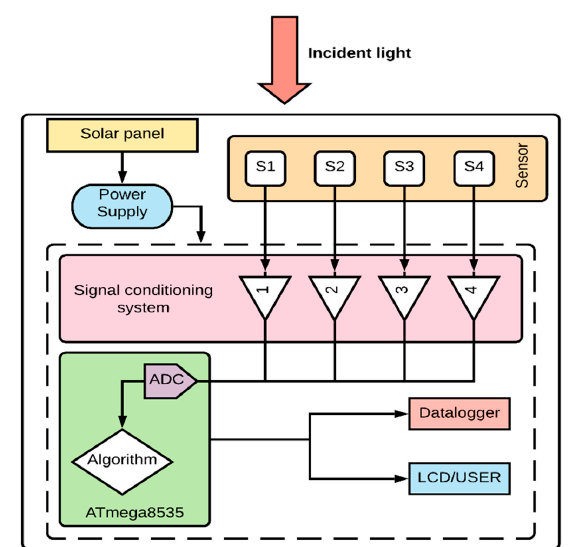
Figure 1. Proposed autonomous system for the measurement of sunshine duration (SD).